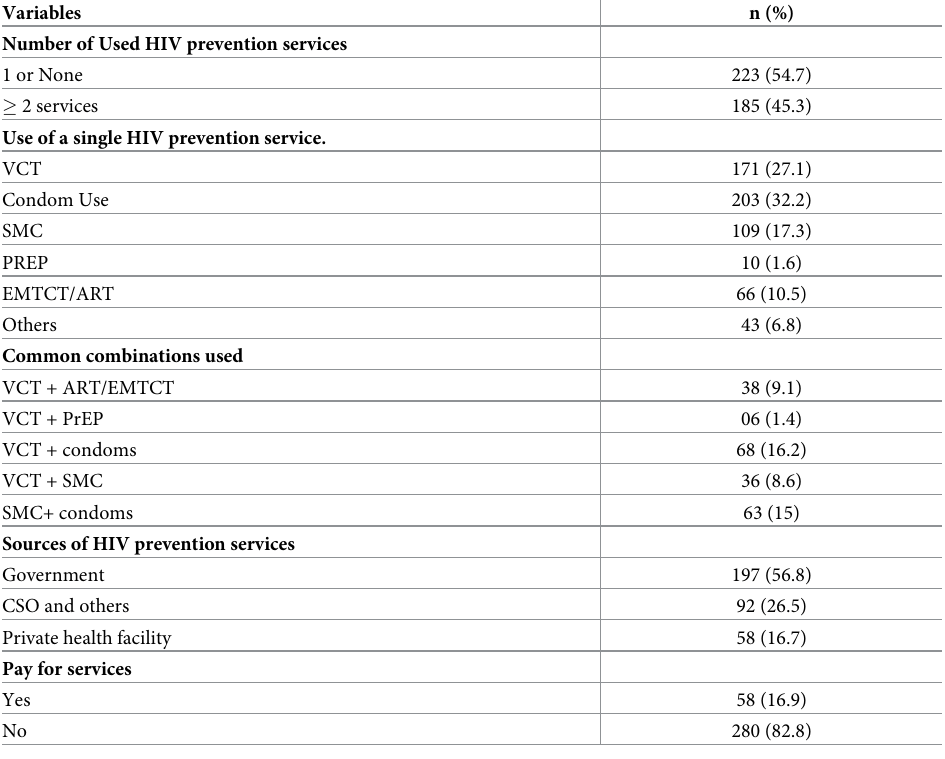
Table 3. Use of HIV prevention services among transport workers in Mbarara city, southwestern Uganda (N = 420).